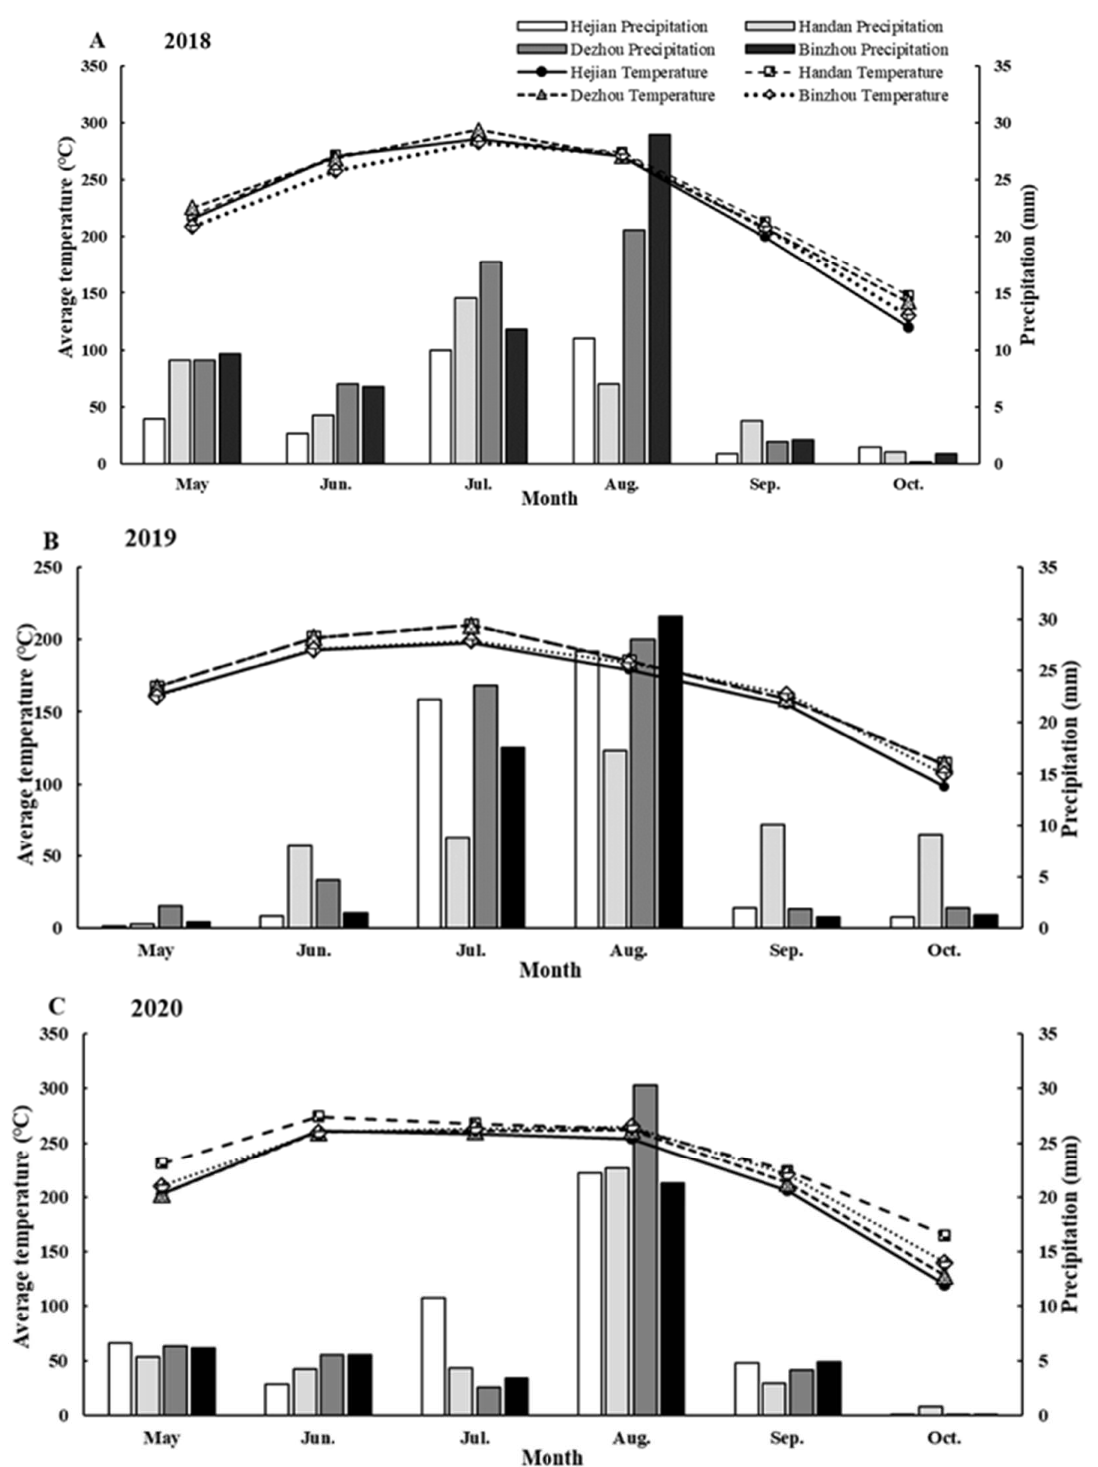
Figure 2. Monthly average temperature and cumulative precipitation during the cotton growing seasons in 2018 ( A ), 2019 ( B ), 2020 ( C ). seasons in 2018 ( A ), 2019 ( B ), 2020 ( C